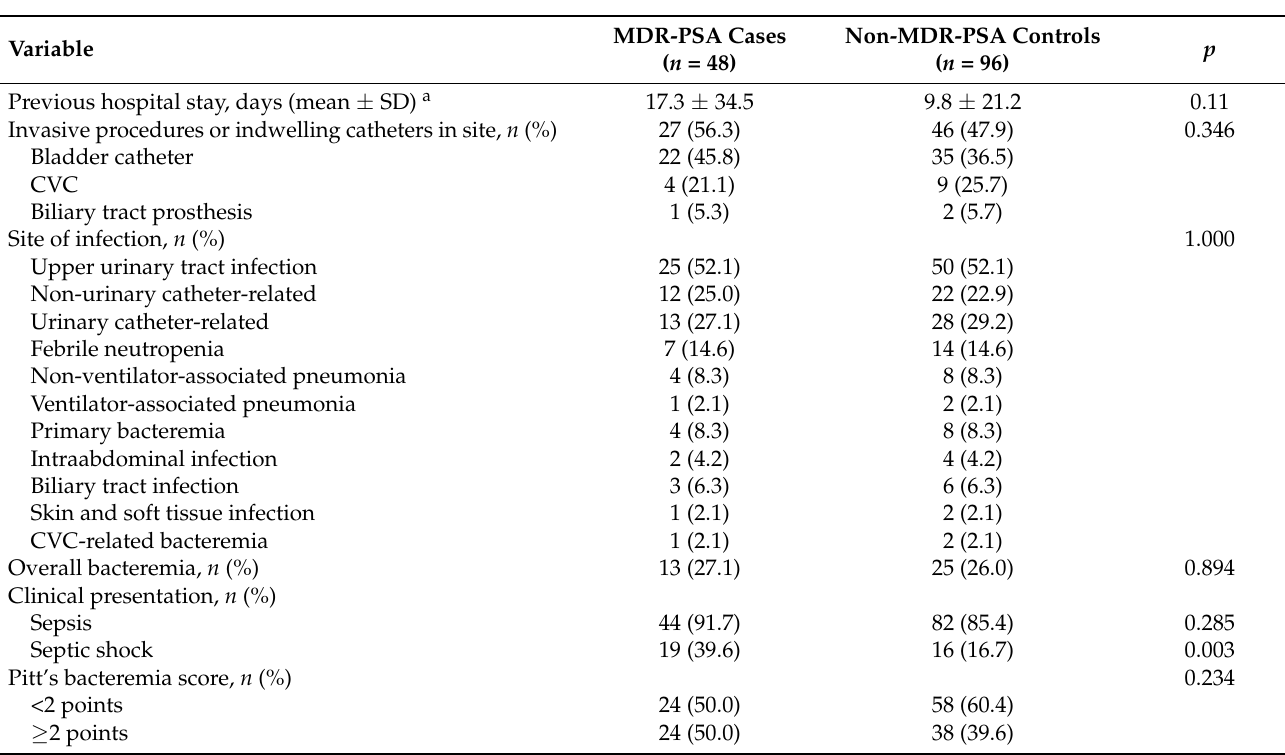
Table 2. Comparison of clinical characteristics of infectious episodes in MDR-PSA cases and non- MDR-PSA